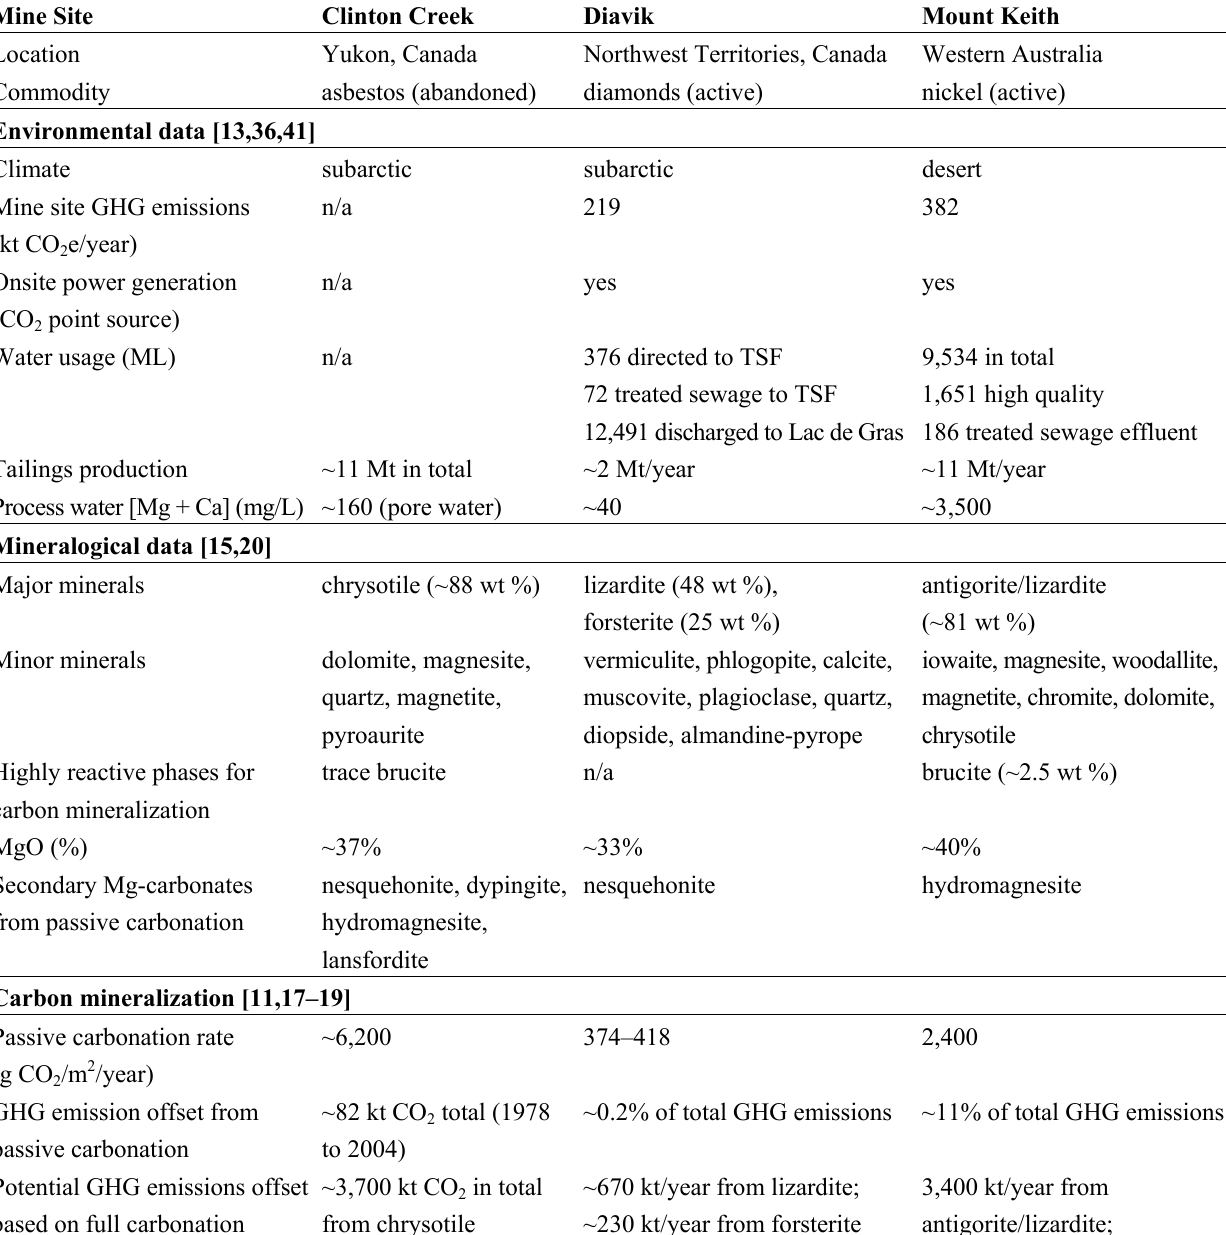
Table 1. Mine sites investigated for carbon